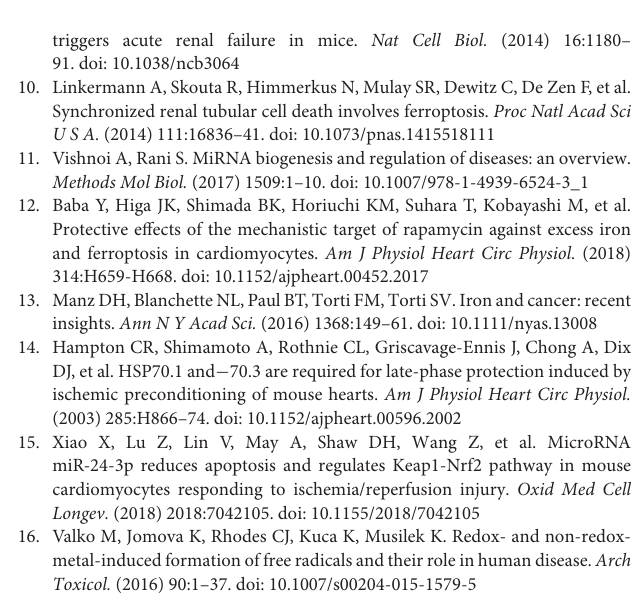
Supplementary Figure 1 | The detailed animal groupings information. Supplementary Figure 2 | The Full Scan WB images in the